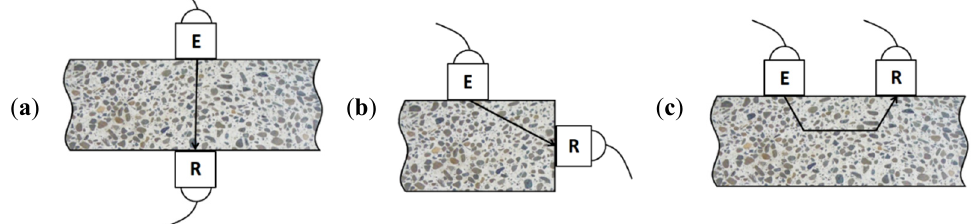
Figure 1. Arrangement of transducers in ultrasonic pulse velocity (UPV) method (based on [10]): ( a ) direct method, ( b ) semi-direct method and ( c ) indirect method. Explanations: E—emitter, R—re- ceiver.